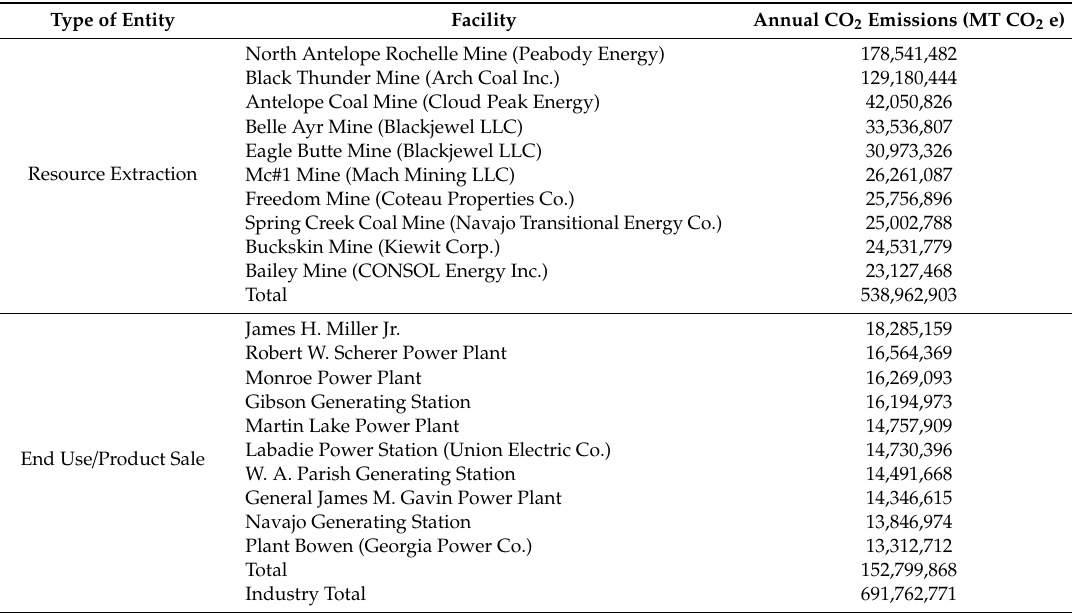
Table A1. Top CO 2 Emission Point-Sources of the Coal Industry for Resource Extraction and